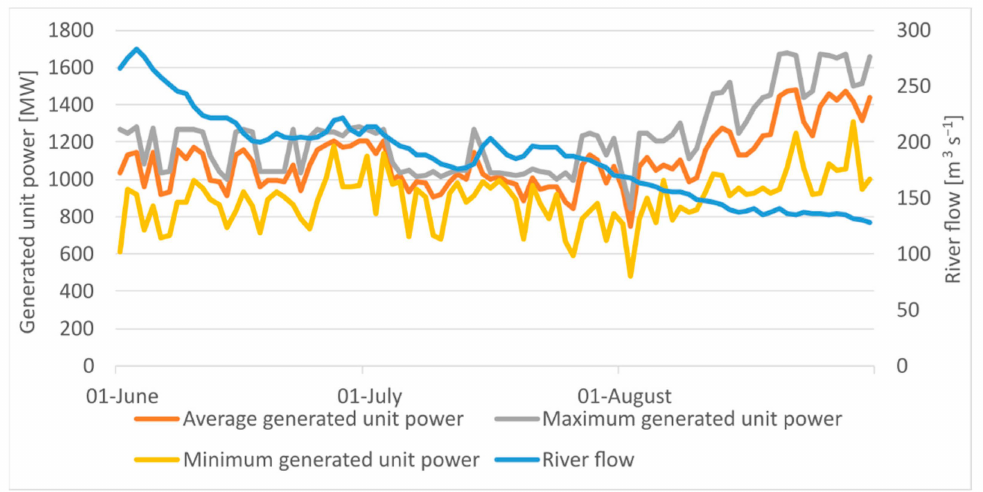
Figure 11. Diagram of the average daily water flow in the Wisła River (Szczucin) along with the minimum, average, and maximum daily power generated in the Połaniec power plant.